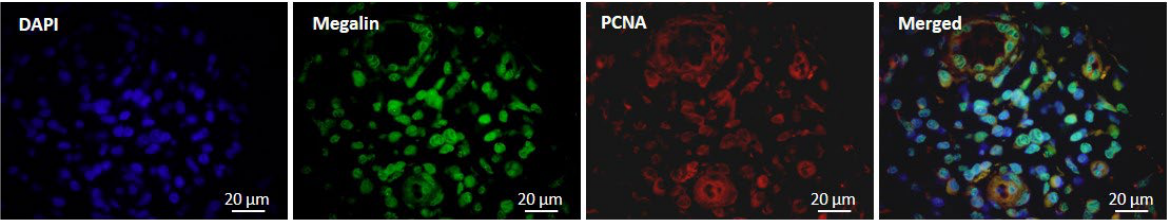
Figure 2. Representative photomicrographs showing double immunofluorescent staining of primary OSCC tissue using anti-megalin and anti-PCNA antibodies.